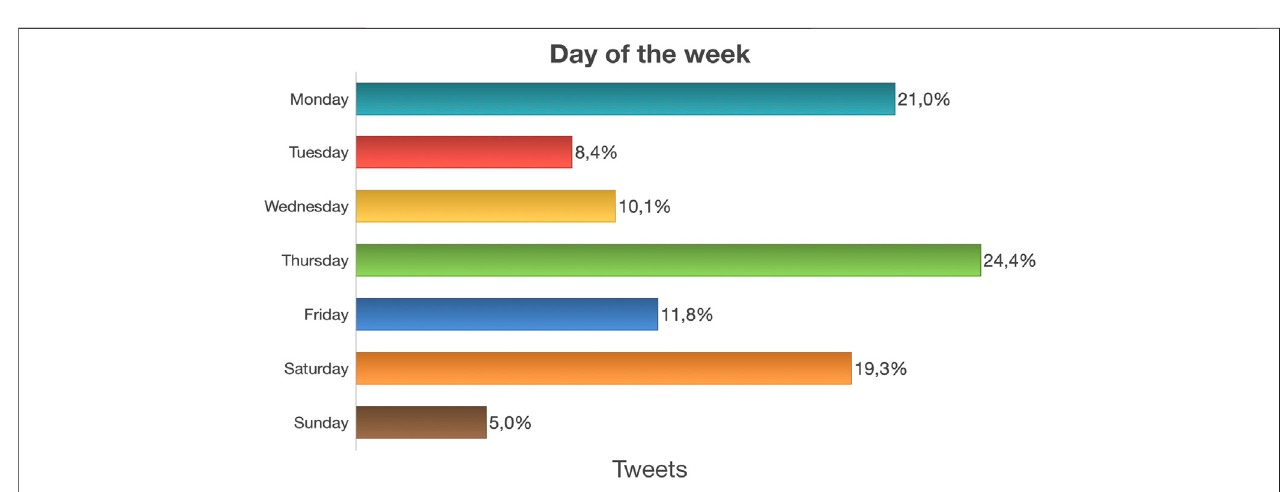
FIGURE 6 | Days of the week of the Congo Check